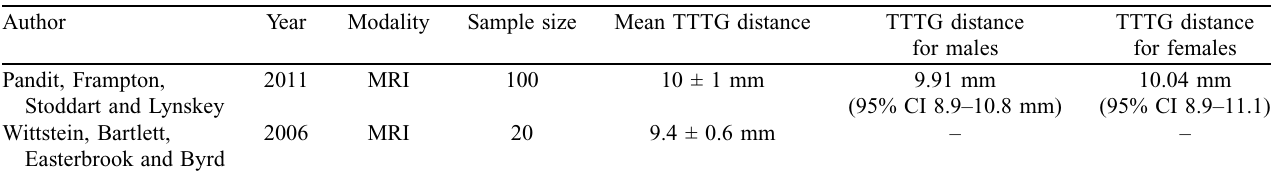
Table 3. Studies showing TTTG distance